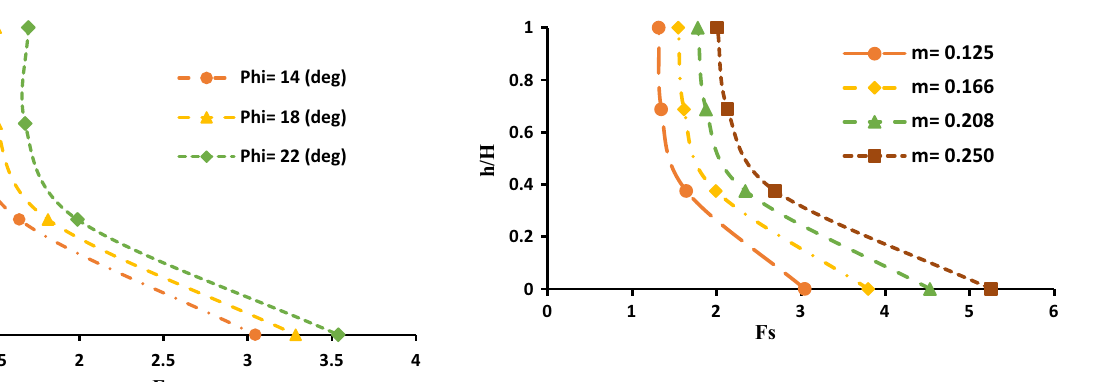
s ) against relative water level ◦ , 𝛽 = 30 ◦